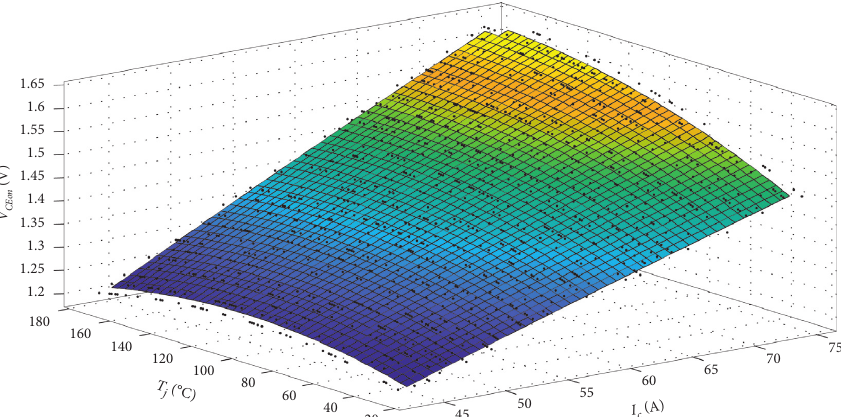
Figure 4: The interpolation graph which is composed of the training set.